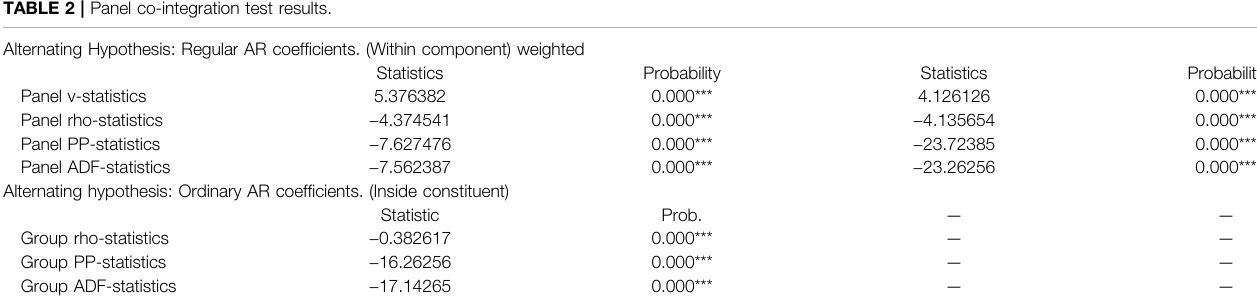
TABLE 2 | Panel co-integration test results.